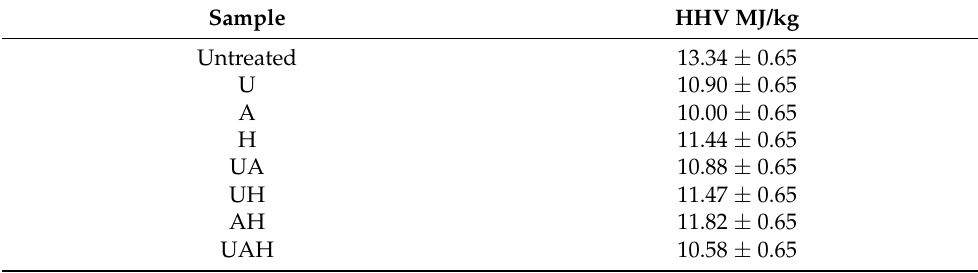
Table 3. Results of HHV from